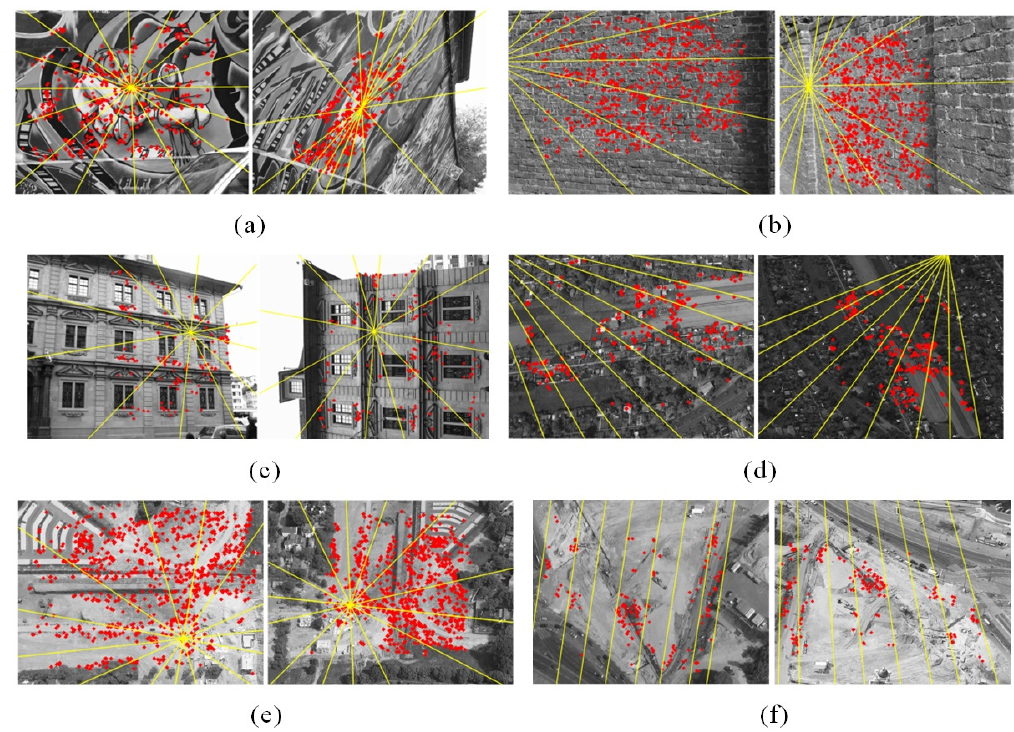
Figure 11. ( a )–( f ) Red points show the matching results of the Morel’s method with groups of stereo images. The yellow lines represent the epipolar lines estimated from matching points.